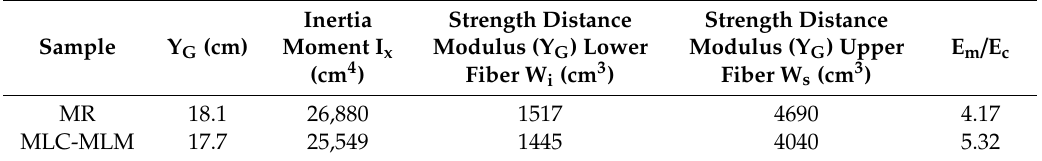
Table 4. Mechanical characteristics and properties of the wood–mortar composite section.